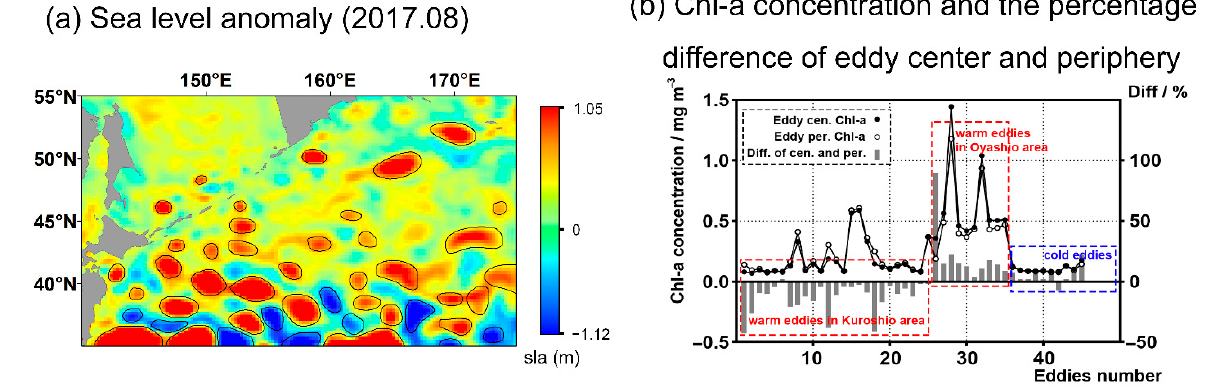
Figure 14. The mesoscale eddies (circled based on SLA data, monthly data of August 2017) and the differences statistics of Chl-a concentration of eddy center and